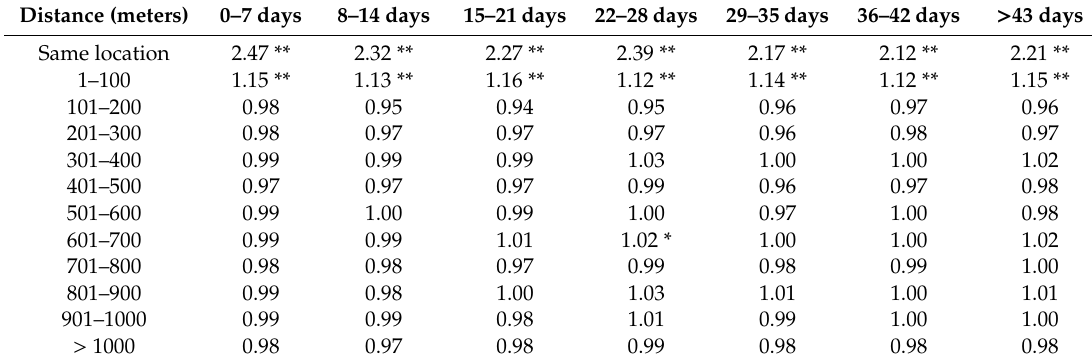
Table 3. Risk of PP after